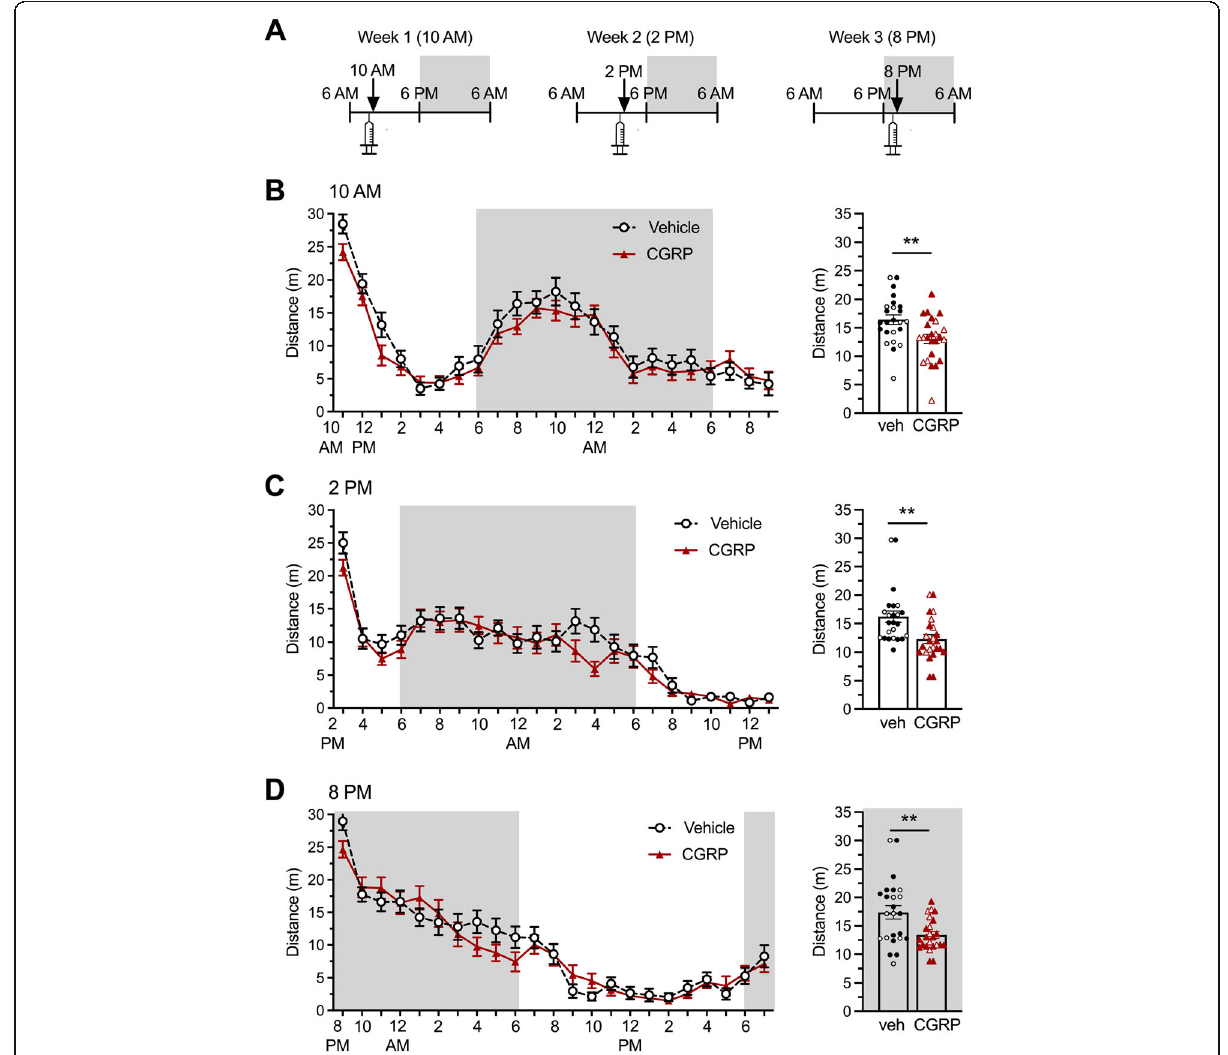
Fig. 1 Peripheral CGRP administration does not change the overall activity of mice throughout the circadian cycle but decreases activity during the first hour after administration. Distance traveled by CD1 mice was measured during 23 consecutive hours starting 30 min after injection of vehicle (PBS, i.p., n = 22) or CGRP (0.1 mg/kg i.p., n = 24), using LABORAS ™ . Each experiment was done a week apart over 3 consecutive weeks with the same animals. In all panels, grey areas represent the active phase of the animals when lights of the facility were turned off (night). Empty symbols represent females, and full symbols represent males. There were no statistical differences between males and females. A Schematics of the experimental protocol. B On week 1, CGRP was administered at 9:30 am and assay started at 10:00 am. Left panel shows the time course of distance travelled over 23 h. Two-way (factors: time x treatment) ANOVA (ns). The right panel shows the average of the distance traveled during the first 30 min of the week 1 test. Unpaired t-test ** p = 0.0063 comparing CGRP with vehicle group. D On week 2, CGRP was administered at 1:30 pm and assay started at 2:00 pm. Left panel shows the time course of distance travelled over 23 h. Two-way (factors: time x treatment) ANOVA (ns). The right panel shows the average of the distance traveled during the first 30 min of the week 2 test. Unpaired t-test ** p = 0.0035 comparing CGRP with vehicle group. F On week 3, CGRP was administered at 7:30 pm and assay started at 8:00 pm. Left panel shows the time course of distance travelled over 23 h. Two-way (factors: time x treatment) ANOVA (interaction and treatment factors ns). The right panel shows the average of the distance traveled during the first 30 min of the week 3 test. Unpaired t-test ** p = 0.0042 comparing CGRP with vehicle